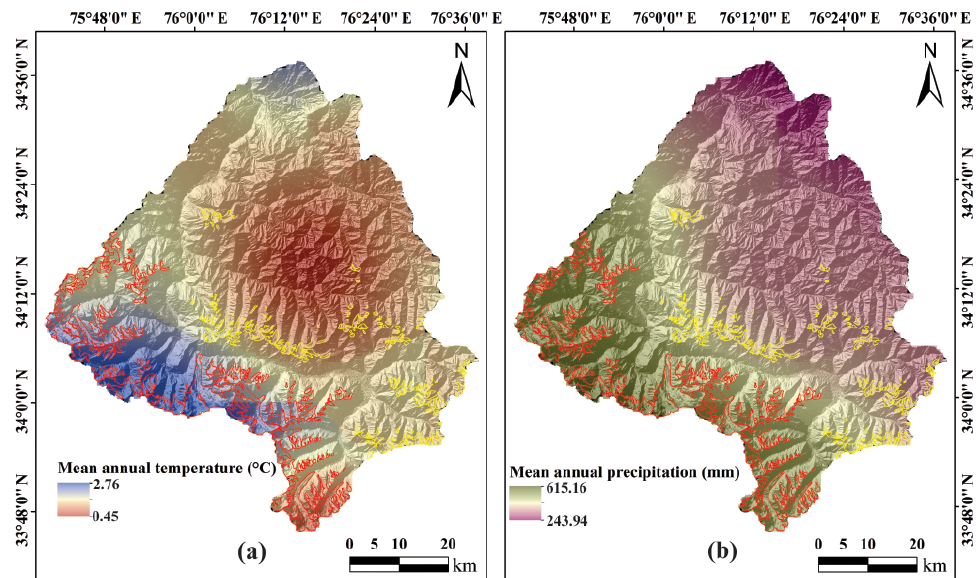
Figure 9. Spatial variation in meteorological data recorded for 15 grids in the SSB during the period 1901–2017. Map showing the long-term mean annual (a) temperature ( ◦ C) and (b) precipitation (mm) data within the sub-basin, suggesting the existence of significant local climate variability in the region. Glacier boundaries are shown as GHR (red) and LR